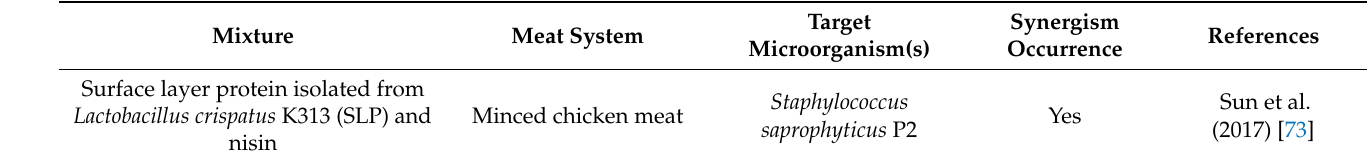
Table 7. The use of a combination of bacteriocin and surface layer protein against a target microor- ganism.